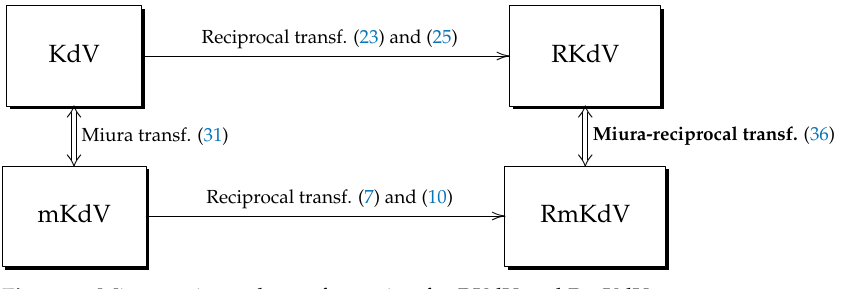
Figure 1. Miura-reciprocal transformation for RKdV and